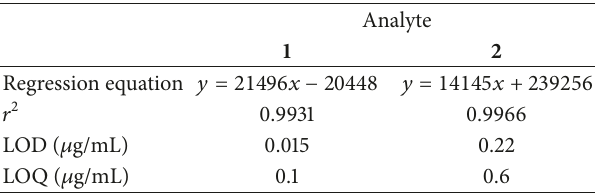
Table 1: Analytical parameters of linearity and limits of detection and quantification obtained for 1 and 2